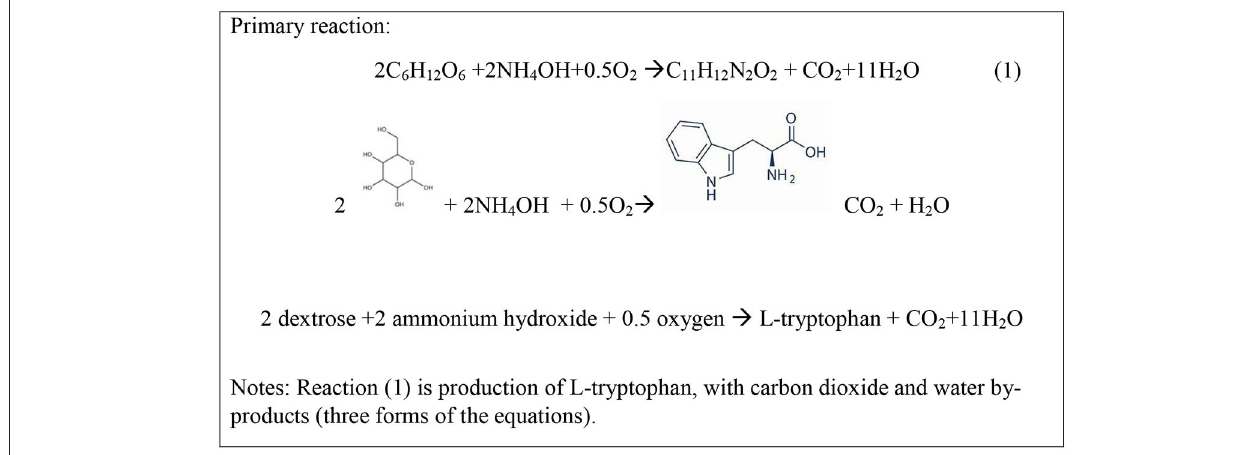
FIGURE 2 | Dextrose role in L-tryptophan synthesis.